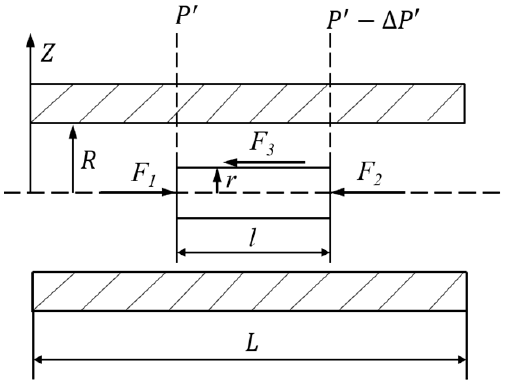
Figure 5. Stress in the ERF in the microchannel.